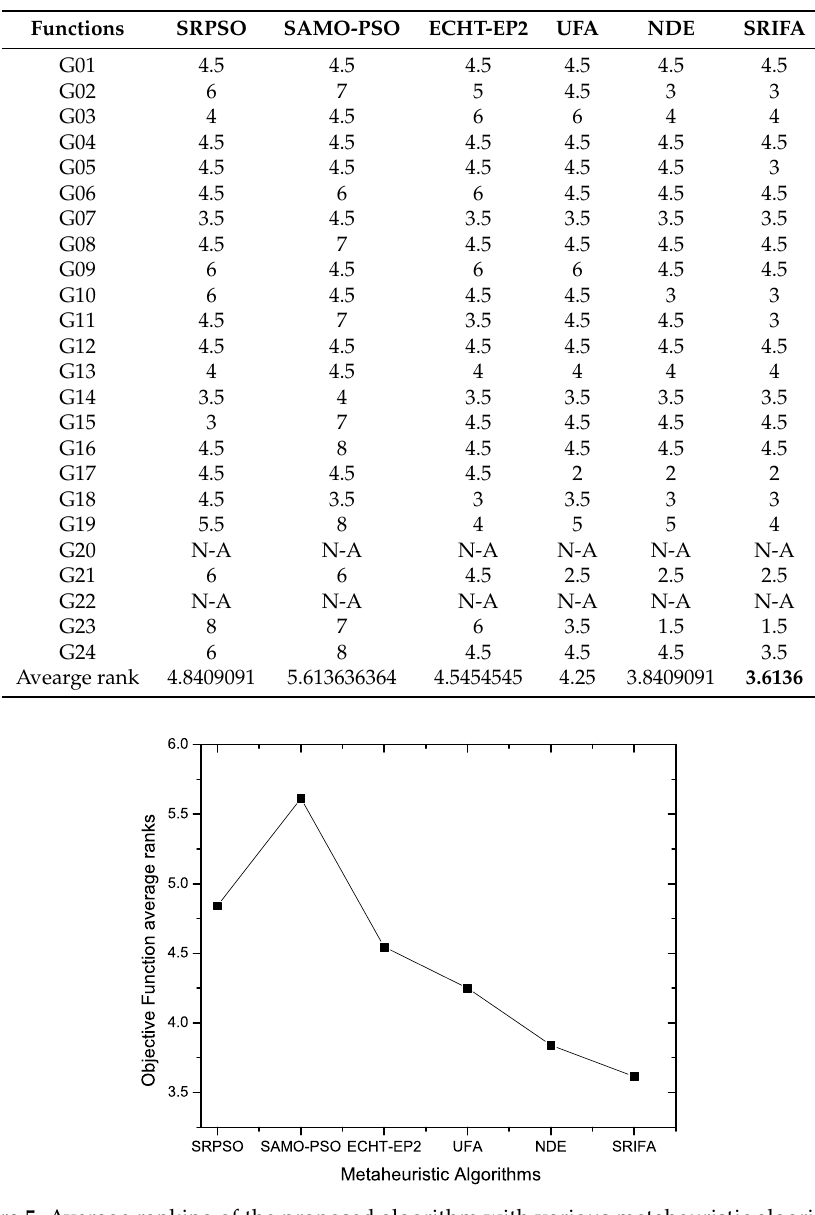
Table 8. Results obtained Friedman test for all metaheuristic algorithms.